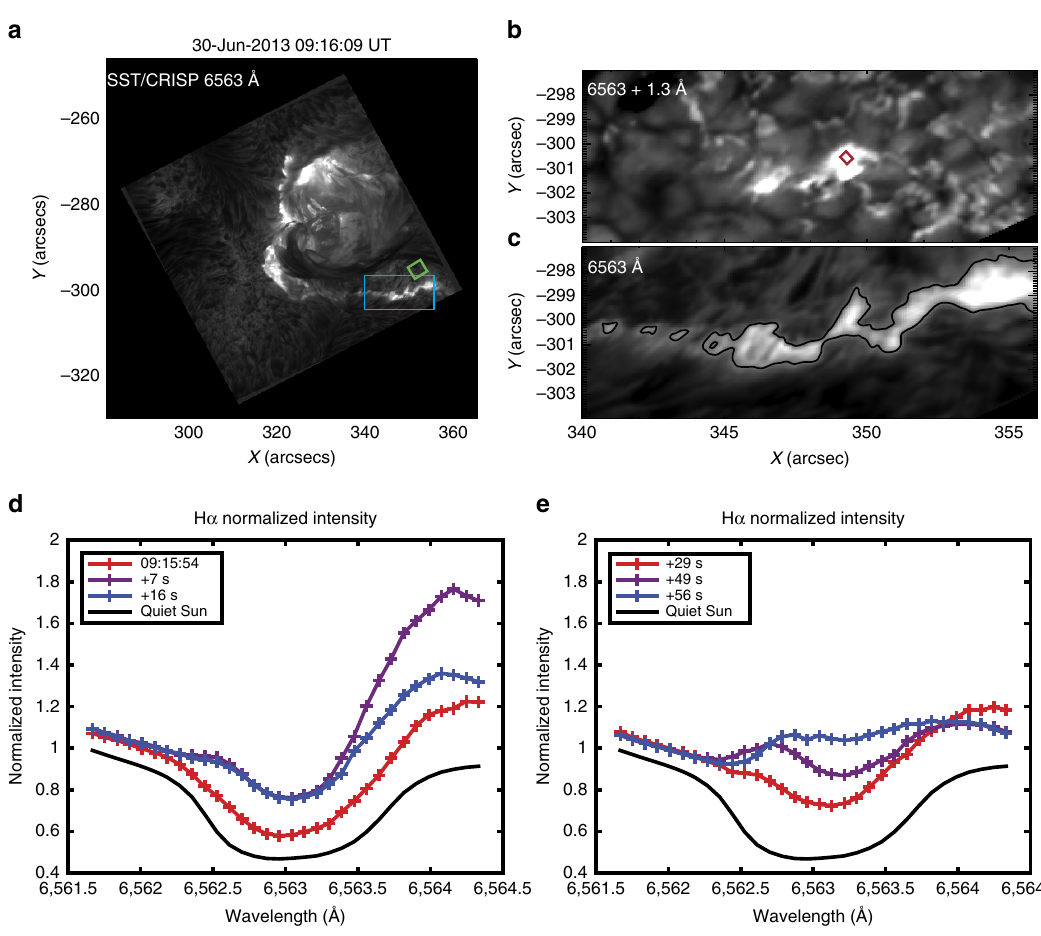
Figure 3 | H a line profile observations using SST. ( a ) The CRISP H a line core image (6,563Å) with a blue box outlining the part of the flare ribbon under investigation. The green box corresponds to the pixels selected to construct the average quiet Sun spectral profiles, ie, close to the ribbon formation and free of any activity, within the time interval of the ribbon formation. ( b ) The corresponding FOV for the H a far red wing intensity at þ 1.3Å, with a red box corresponding to the region where the spectral profiles of interest are extracted. ( c ) The contoured ribbons of the H a line core image for the blue box region is presented. ( d ) The averaged and normalized H a spectral line profiles, determined from the red box pixels, are presented for time intervals corresponding to the 1st (09:15:54 UT: red solid line), the second ( þ 7s: purple solid line) and the third ( þ 16s: blue solid line) time frames. The H a line profiles display exceptionally strong red-shifts. ( e ) The averaged and normalized H a spectral line profiles for significantly later time frames corresponding to þ 29s (red solid line), þ 49s (purple solid line) and þ 56s (blue solid line) when there were no longer strong red-shifts but rather core emission with peaks in both blue and red near wings. The black solid lines describes the averaged QS background H a profile, deduced from the region defined by the green box in a . Intensities were normalized against the background levels using the QS intensity of 9,890 counts per pixel at 6561.7Å; as a used in panels b and c. In Fig. 3b we see the image taken in the Corona—Fe xii 171Å; Flaring/hot Corona—Fe xxiii 94Å) were red wing of H a at 6,564.376 Å and Fig. 3c shows the line core. To reduced and aligned to 1,700Å, via the aia _ prep routine in assess the feature identified, data was extracted from a 5 (cid:3) 5 pixel SolarSoft Interactive Data Language (SSWIDL). Subsequent images square (215 km 2 ), which contained the region of the greatest red in all AIA channels were de-rotated to the CRISP start time wing enhancement in the 09:16:01 UT frame. This kernel area is (Fig. 2). The SST telescope turret continually tracked the starting highlighted by the red square in Fig. 3b. The resulting H a line profiles are shown in Fig. 3d,e. The CRISP observation captured the onset of a strong chromospheric downflow in the second ribbon area highlighted by the blue box in Fig. 3a. The red wing enhancement started in the 09:15:54 UT frame (Fig. 3d, red line), increased between 09:15:54 and 09:16:01 UT and peaked at 09:16:01 UT (Fig. 3d, purple line), 7 s after the flare onset. Contrary to the symmetric H a line profile of the QS, the emission in the red wing exhibited a single-peaked profile (Fig. 3d). This suggests that the peak can be attributed to a strong downflow in the chromosphere with Doppler velocity of 45–50 km s (cid:2) 1 . This red wing enhancement was reduced 9 s later, while the core emission remained at a slightly raised level, compared to the QS (Fig. 3d, blue line).